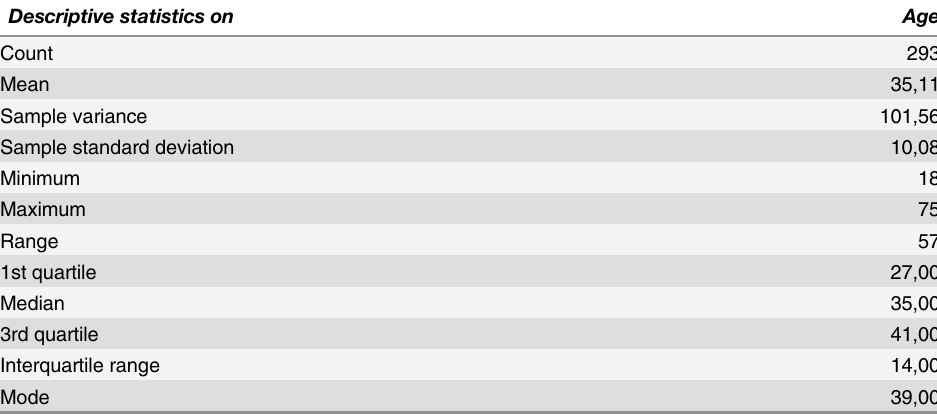
Table 2. Descriptive statistics on age of patients in this